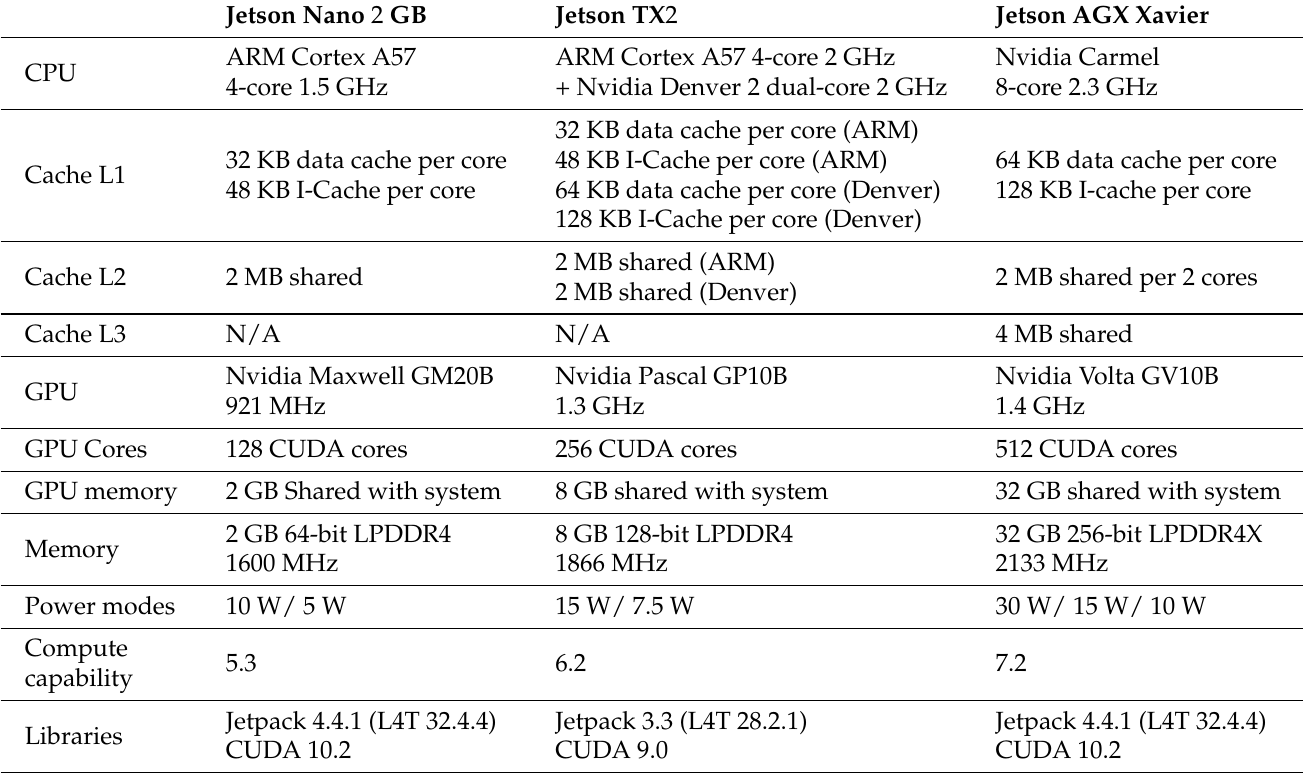
Table 1. Summary of Nvidia’s Jetson platform specifications.